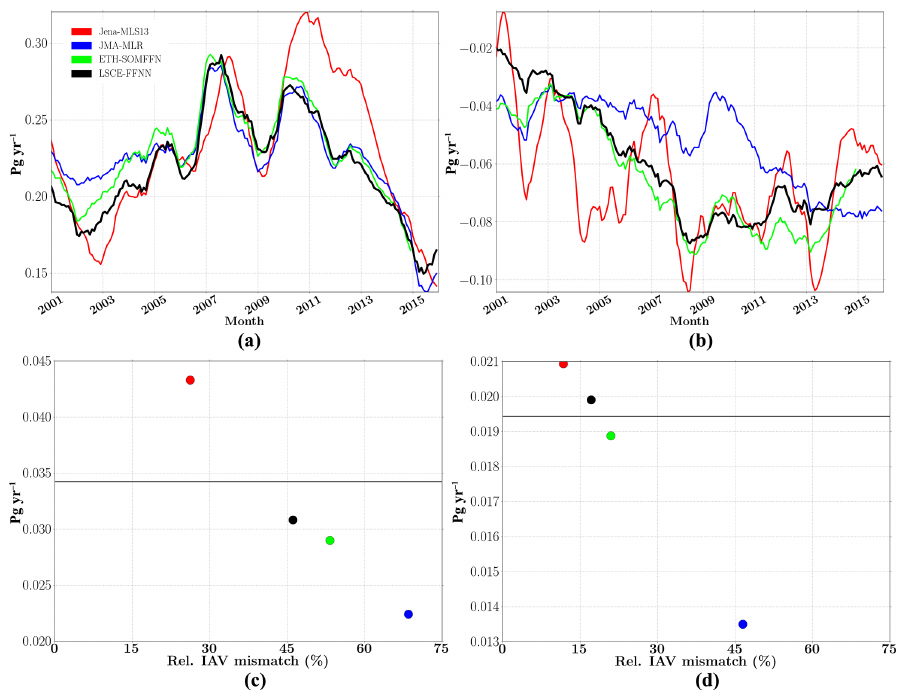
Figure 7. Global ocean interannual sea–air CO 2 flux (12-month running mean) in (a) the equatorial East Pacific (biome 6) and (b) the sub- tropical permanently stratified North Atlantic (biome 11). The amplitude of interannual CO 2 flux plotted against the relative IAV mismatch amplitude in (c) the equatorial East Pacific (biome 6) and (d) the subtropical permanently stratified North Atlantic (biome 11). The weighted mean is given as a horizontal line.